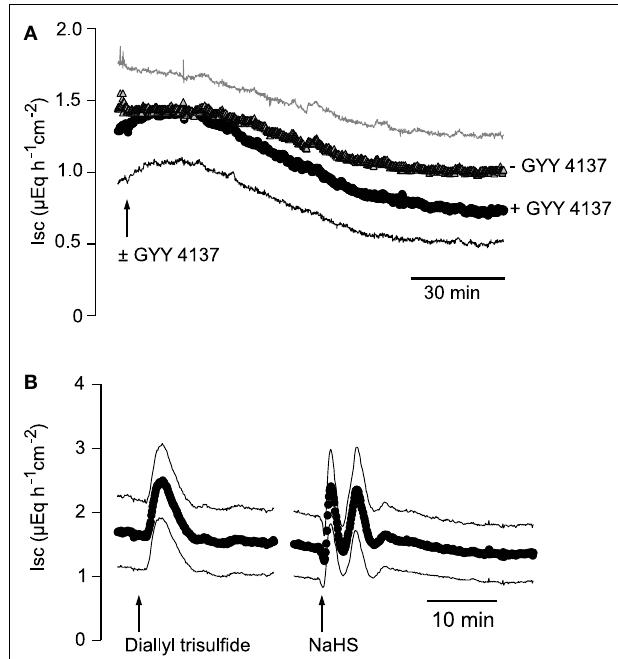
FIGURE 4 | (A) Comparison of the Isc evoked by different H 2 S donors.The very slow H 2 S-releasing molecule, GYY 4137 (5 × 10 − 5 mol · l − 1 at the serosal side; arrow; black symbols and curve marked with + GYY 4137), did not evoke an increase in Isc in mucosa–submucosa preparations of rat distal colon. In contrast, a slow decrease in Isc, which had the tendency (not statistically significant) to be more pronounced compared to time-dependent control experiments ( − GYY 4137) not pretreated with GYY 4137 (gray symbols) was observed. (B) The slow H 2 S donor, diallyl trisulfide (1.5 × 10 − 5 mol · l − 1 at the serosal side; left arrow), causes a transient, monophasic increase in Isc, whereas the fast H 2 S donor, NaHS, administered in an equieffective concentration (2.5 × 10 − 3 mol · l − 1 at the serosal side; right arrow), induced a triphasic change in Isc.Values are means (symbols) ± SEM (lines), n = 5–7. In the case of the experiments with GYY 4137, for graphical reasons for the time-dependent control experiments ( − GYY 4137) only + SEM (gray line) and for the group treated with GYY 4137 ( + GY 4137) only − SEM (black line) are shown. For statistics, see